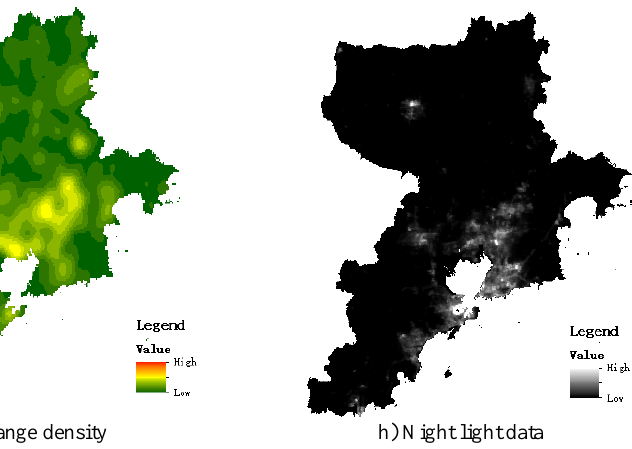
Figure 3. Inversion results of other factors